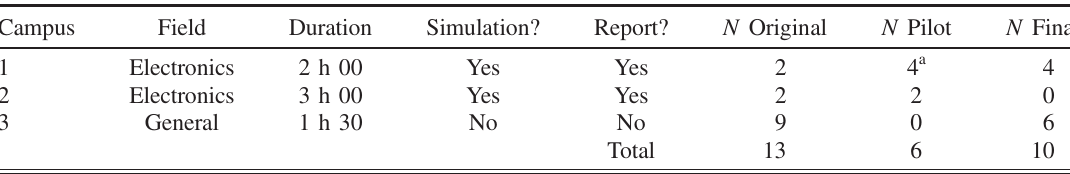
TABLE I. Overview of settings and number of student pairs filmed, organized by campus. Campus